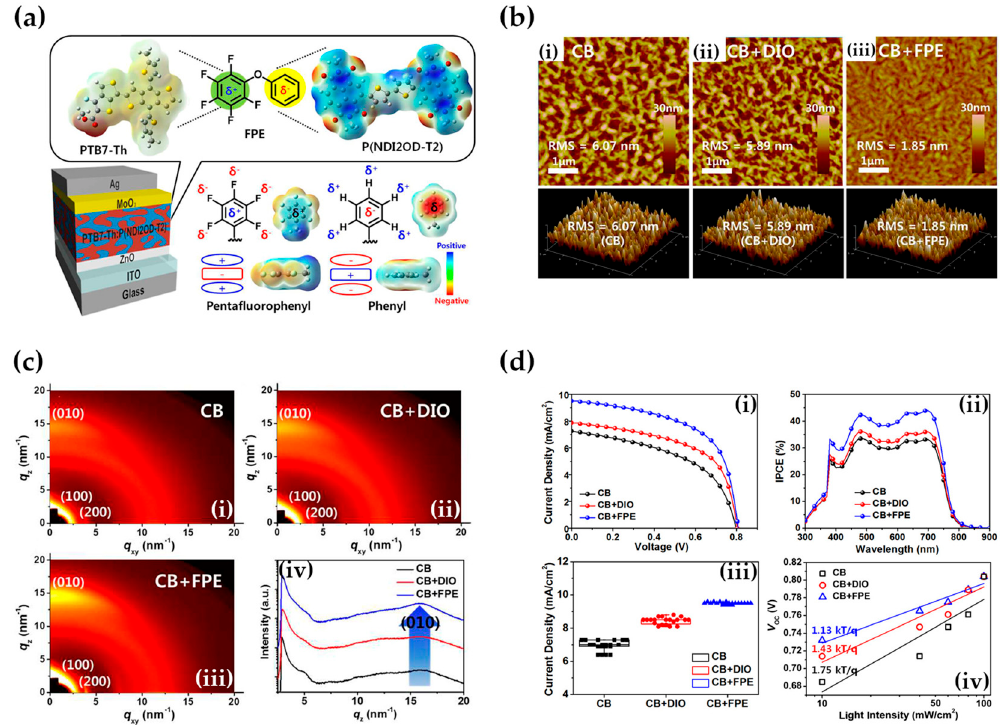
Figure 10. Pentafluorobenzene-based compatibilizers in all-PSCs. ( a ) Control of the interfacial morphology between PTB7-Th and P(NDI2OD-T2) blend films via electrostatic interactions with pentafluoro-6-phenoxybenzene (FPE). ( b ) AFM characterization (height at the top, 3D images at the bottom) of the TB7-Th:P(NDI2OD-T2) blend films processed with (i) CB, (ii) CB + DIO, and (iii) CB + FPE. Note that CB stays here for chlorobenzene, DIO for 1,8-diiodooctane. ( c ) GIWAXS graphs of PTB7-Th:P(NDI2OD-T2) blend films processed with (i) CB, (ii) CB + DIO, and (iii) CB + FPE; (iv) corresponding GIWAXS out-of-plane patterns for the three cases. ( d ) Photovoltaic characterization of the devices processed with CB, CB + DIO, and CB + FPE, by reporting the (i) J − V graph, (ii) IPCE spectra, (iii) statistical analysis of J SC , and (iv) the V OC as a function of the light intensity. Reproduced with permission from Reference [167]. Copyright (2017) American Chemical Society.